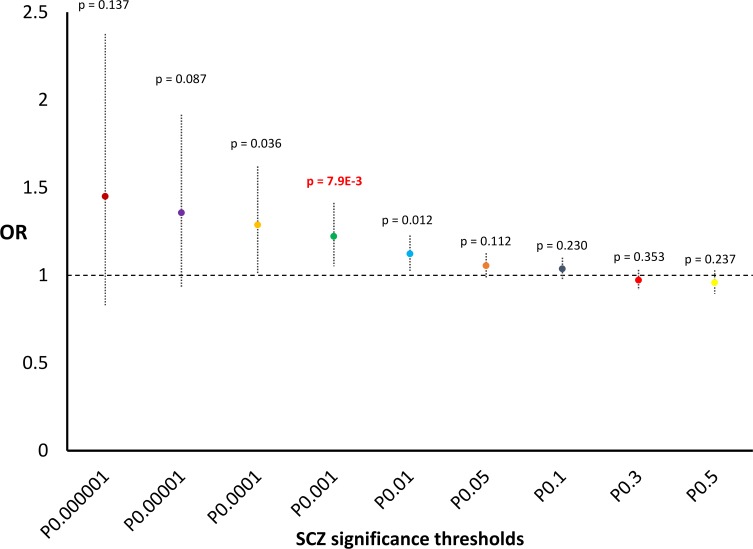
Genome-wide enrichments for scores related to incomplete selection considering different SCZ significance thresholds.Odds Ratio, 95% confidence interval, and p value are reported for each threshold investigated.